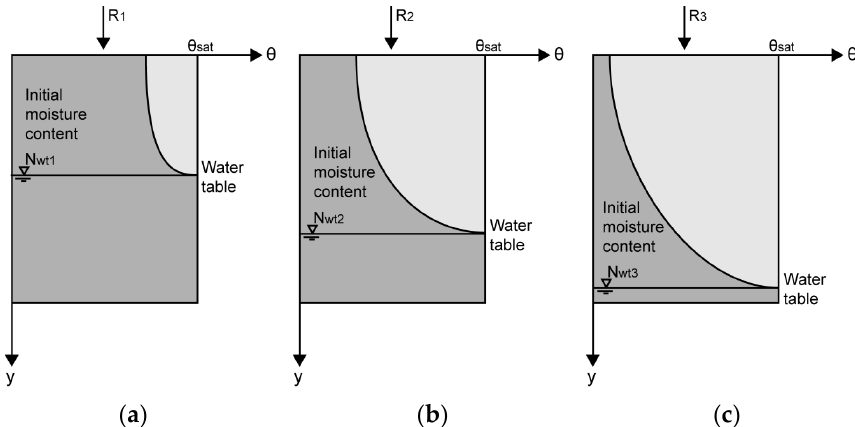
Figure 4. Initial state and water table position in a cell for different recharges R 1 > R 2 > R 3 : ( a ) R 1 generates an initial state with a high water table and a soil moisture close to the saturation soil moisture; ( b ) R 2 generates an initial state with an intermediate water table and a soil moisture; and ( c ) R 3 generates an initial state with a low water table and a soil moisture close to the residual soil